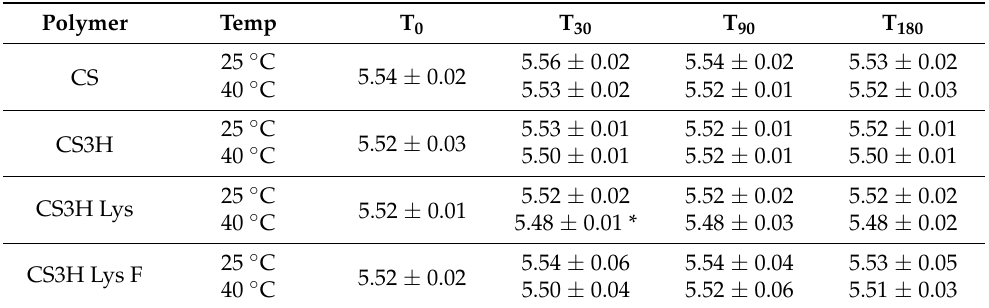
Table 5. The effect of temperature on the pH of chitosan mouthwash formulation. Data are expressed as mean ± SD, n = 3. Two-way ANOVA followed by Sidak’s test was carried out (* p < 0.05 compared to T 0